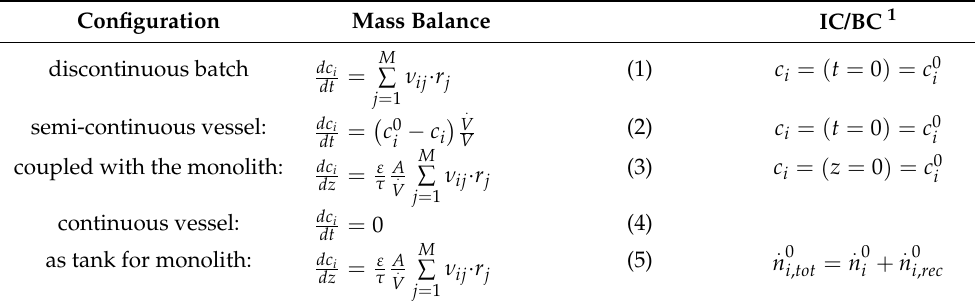
Table 4. Experimental and model-based characterization of the monolithic reactor.